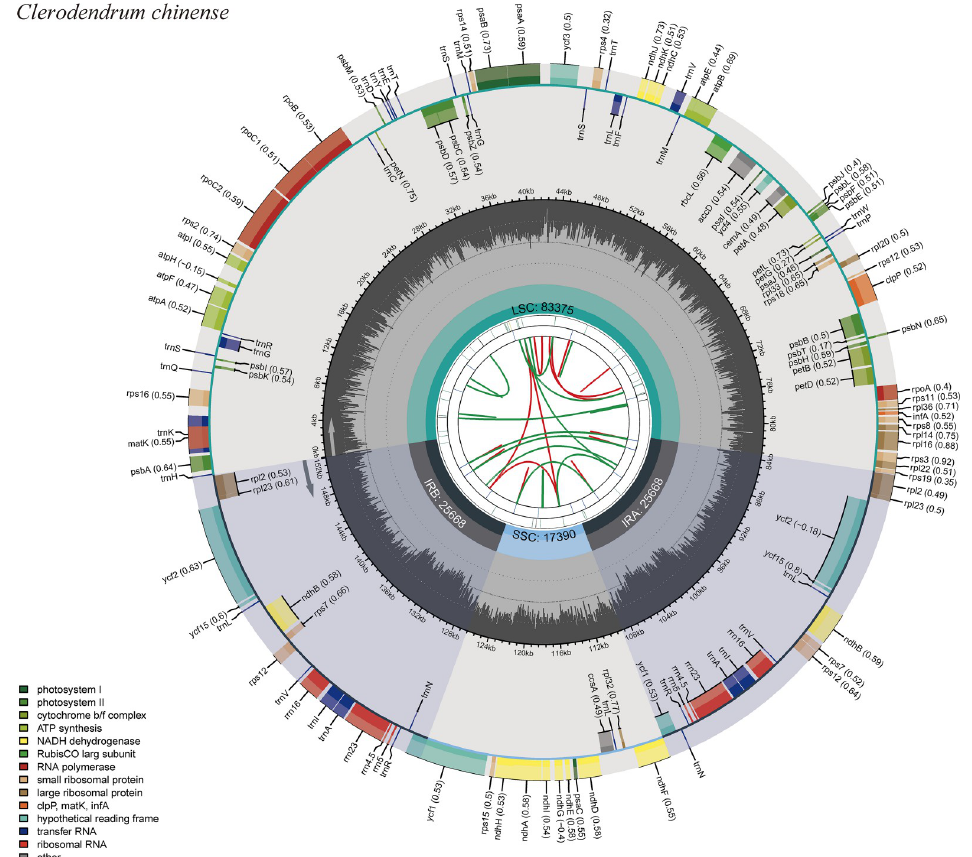
Fig 1. Gene map of the C . chinense plastome. There are six rings on the diagram from the center outwards. The first ring is used to indicate the position of forward (red arcs) and reverse (green arcs) repeats. The second ring is used to indicate tandem repeats (short columns). The third ring is used to indicate microsatellite repeats (short columns). The fourth shaded ring indicates each part and the length of SSC, IRa, IRb, and LSC regions. The optional shaded area stretching from the inner sphere toward the outer circle marks the IR regions The fifth ring indicates the GC content of the chloroplast genome. The outer ring shows the gene names and their optional codon usage bias. The genes are colored based on their functional